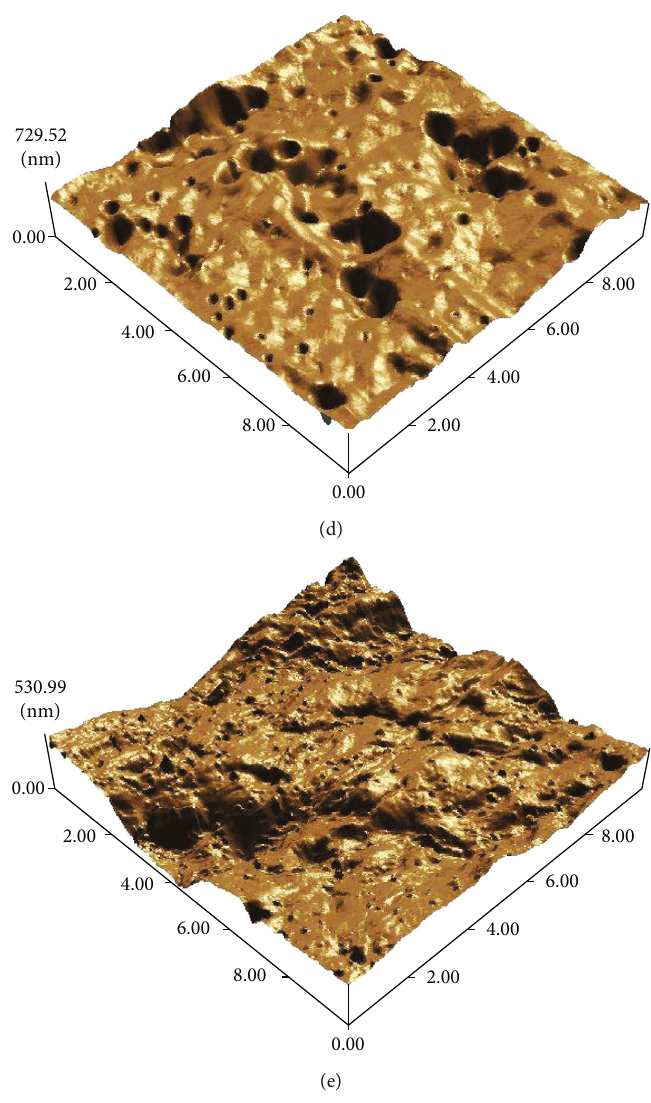
Figure 6: AFM surface topography image PESVP membranes: (a) PESVP2-1; (b) PESVP2-2; (c) PESVP2-3; (d) PESVP2-4; (e)